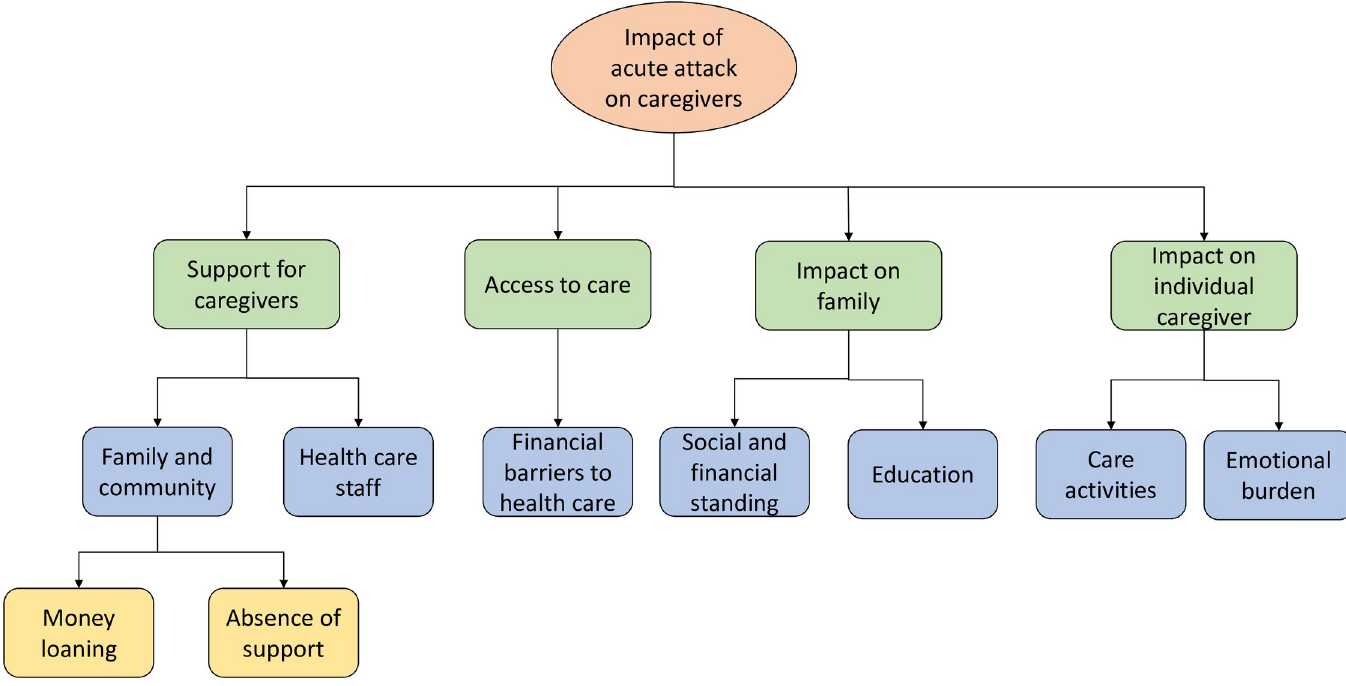
Fig 1. Themes and subthemes